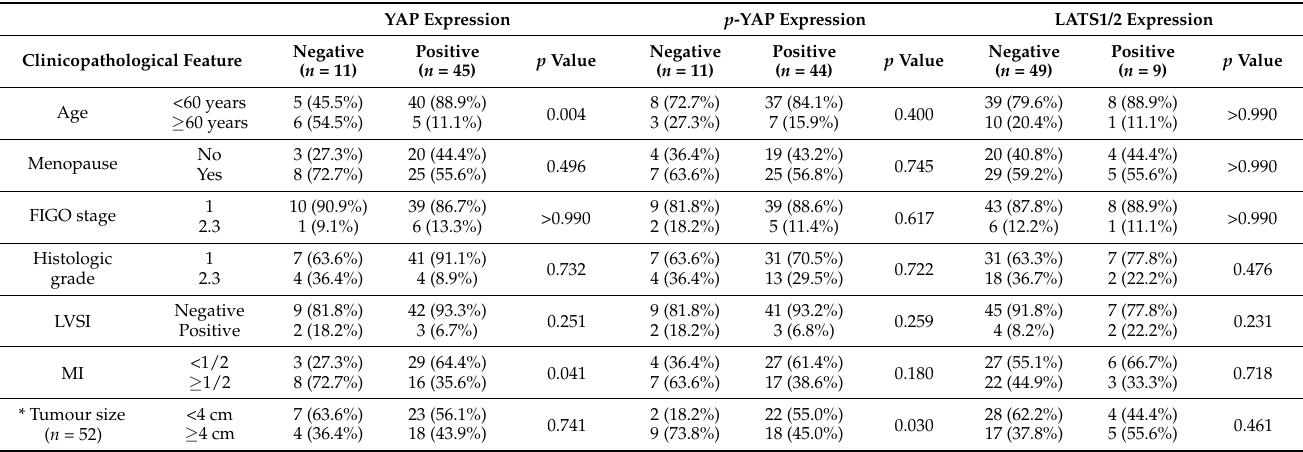
Table 3. Association between clinicopathological features and expression of YAP, p -YAP, and LATS1/2.